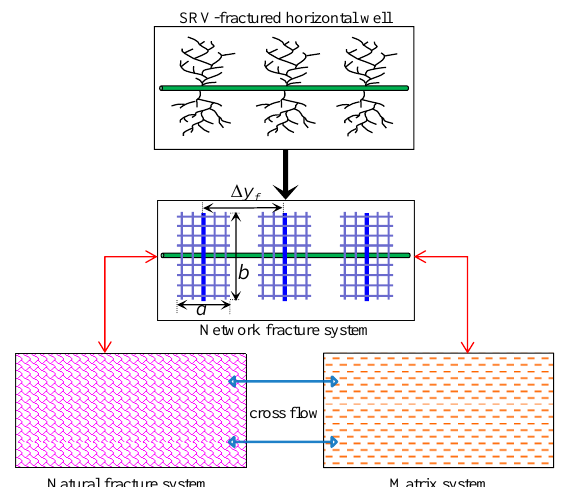
Figure 1. Physical model diagram of the SRV-fractured horizontal well with multi-porosity media.